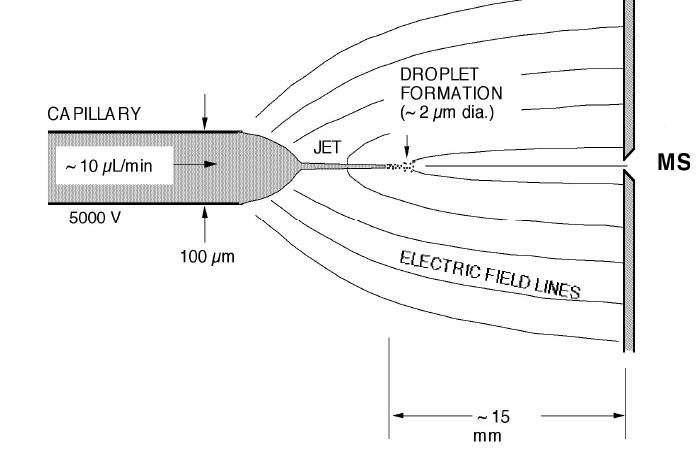
Figure 2 . A typical electrospray